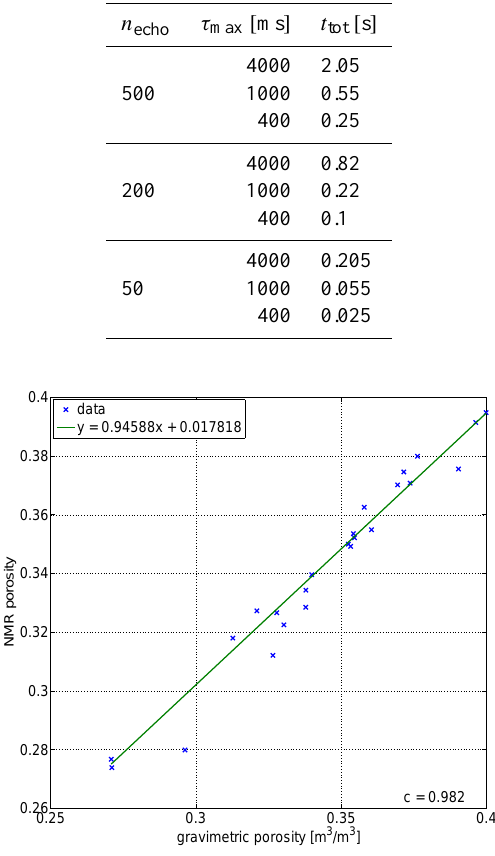
Fig. 6. Cross-plot of porosities determined via NMR- and gravimetric-measurements. The NMR-porosity is in excellent agreement with the gravimetric ones, which is validated by the cor- relation coefficient of c